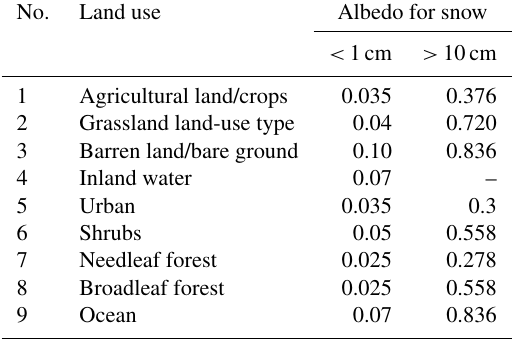
Table 4. Tabulated values from Laepple et al. (2005) and Tanskan- nen and Manninen (2007) used for the calculation of the albedo in the UV band. In the presence of sea ice over ocean, the albedo of the ice surface is assumed equal to the Tanskannen and Manninen (2007) value for > 10cm of snow on barren